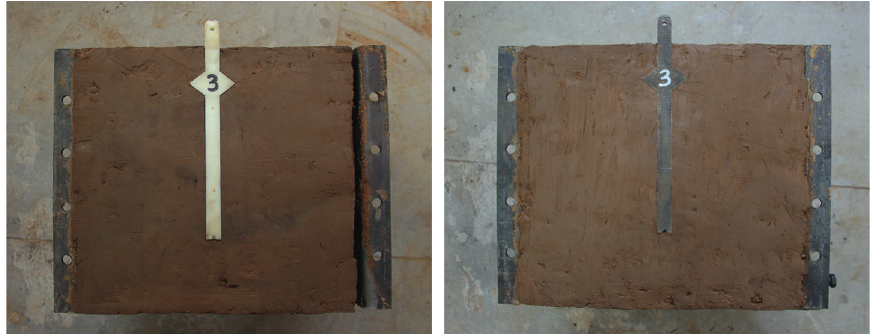
Figure 12: Drying the surface water.